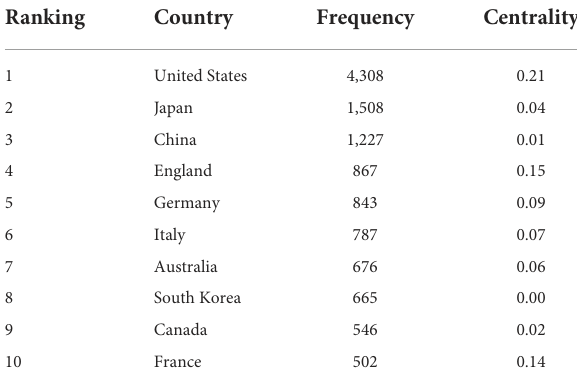
TABLE 1 The top ten productive countries and centrality in the research field of dysphagia from 2012 to 2022.